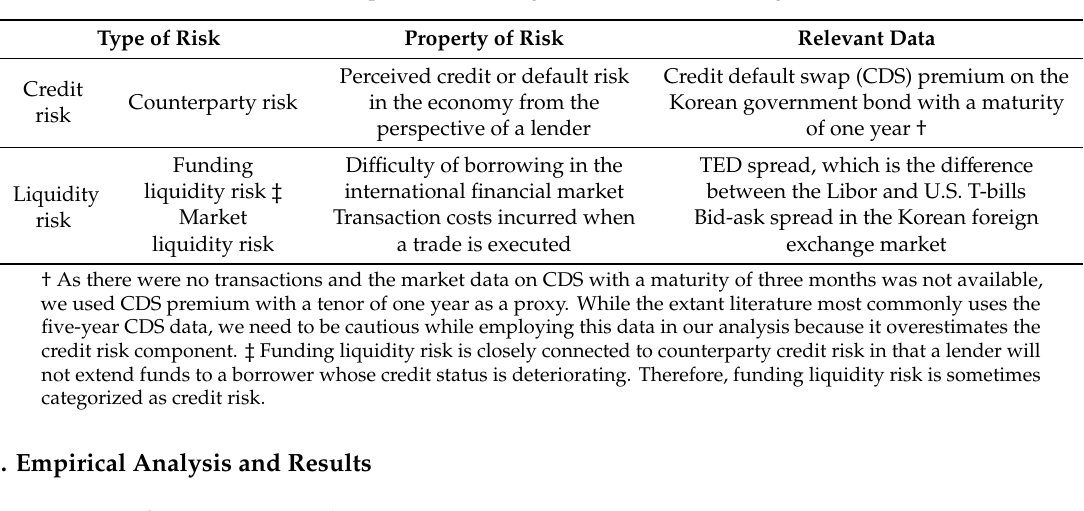
Table 2. The risk components entailing the interest rate arbitrage